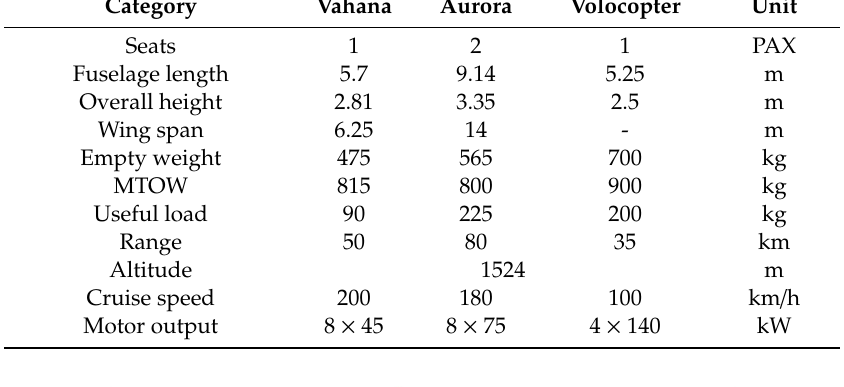
Table 2. eVTOL PAV specification.